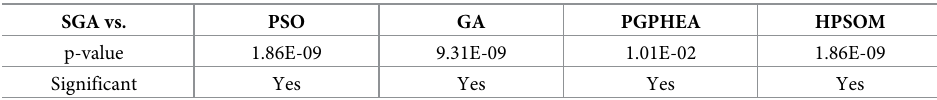
Table 10. Wilcoxon signed-rank-test ( p � 0.05) for average error/ in CEC 2017